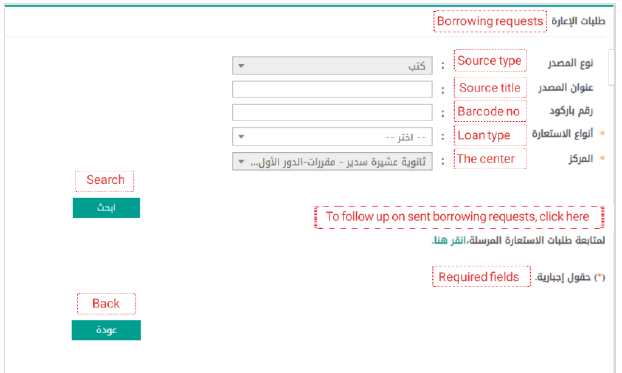
Figure 9. Borrowing a book task with an overlay translation in red.